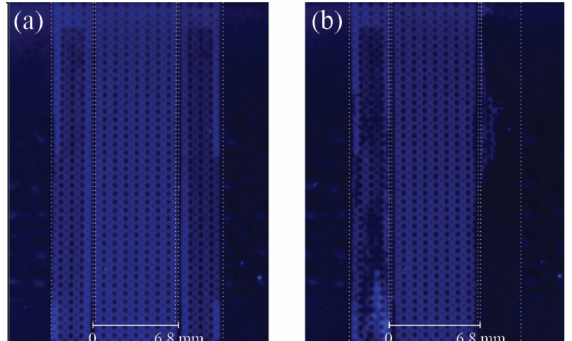
Figure 9. Fluorescence images of the microfluidic chamber filled with 4MU solution (0.25 mM 4MU, 0.2% of HPMC in 10 mM HEPES, pH 7.0), ( a ) before the experiment and ( b ) after the